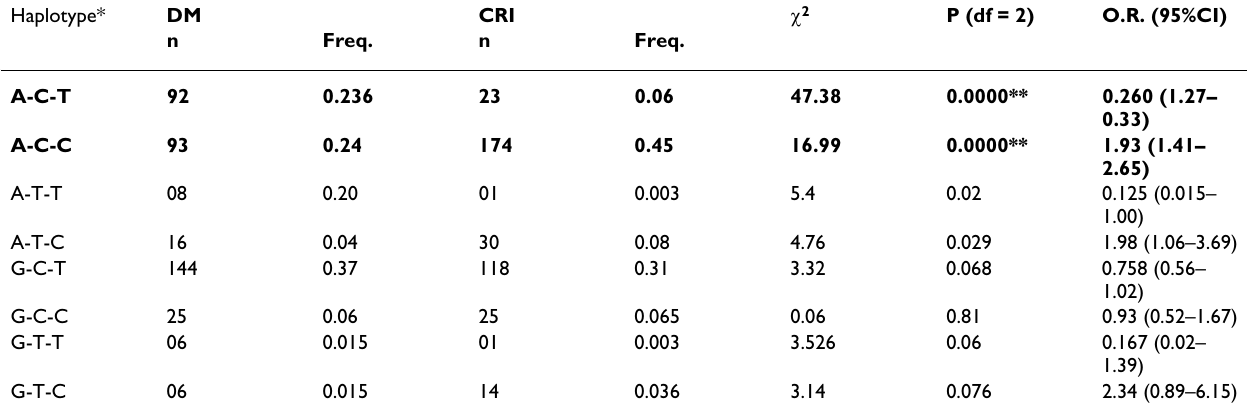
Table 4: Haplotypes of A>G (-6) – Thr174Met – Met235Thr SNPs in AGT gene tested for association with diabetic chronic renal insufficiency.